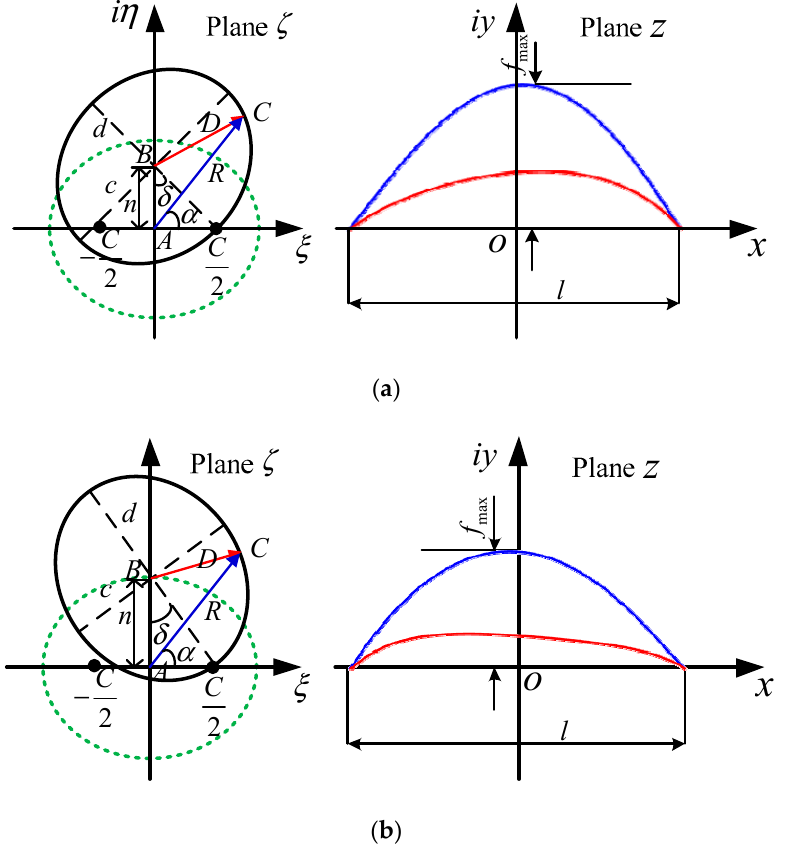
Figure 6. Airfoil with a variable relative camber position. ( a ) Translation of the major axis of the ellipse along the imaginary axis; ( b ) Translation of the minor axis of the ellipse along the imaginary axis.